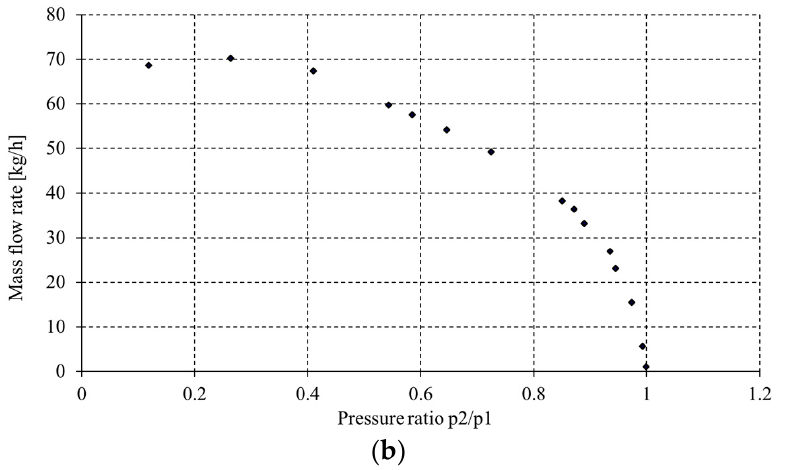
Figure 9. Dependence of the mass flow rate on the pressure ratio for the OBREiUP G1/8 manifold No. 611.012.949, working position: ( a ) currentless, ( b ) coil energized.